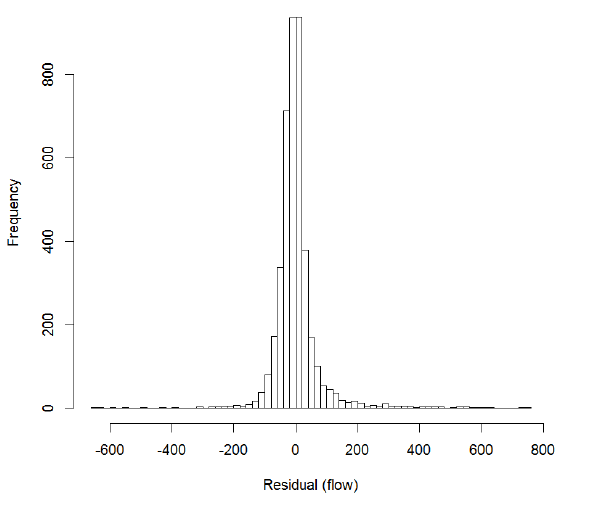
Figure 2. Histogram of residuals of model 6